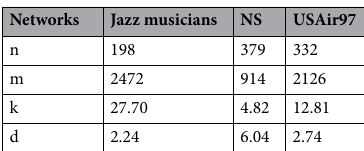
Table 1. Basic characteristics of the